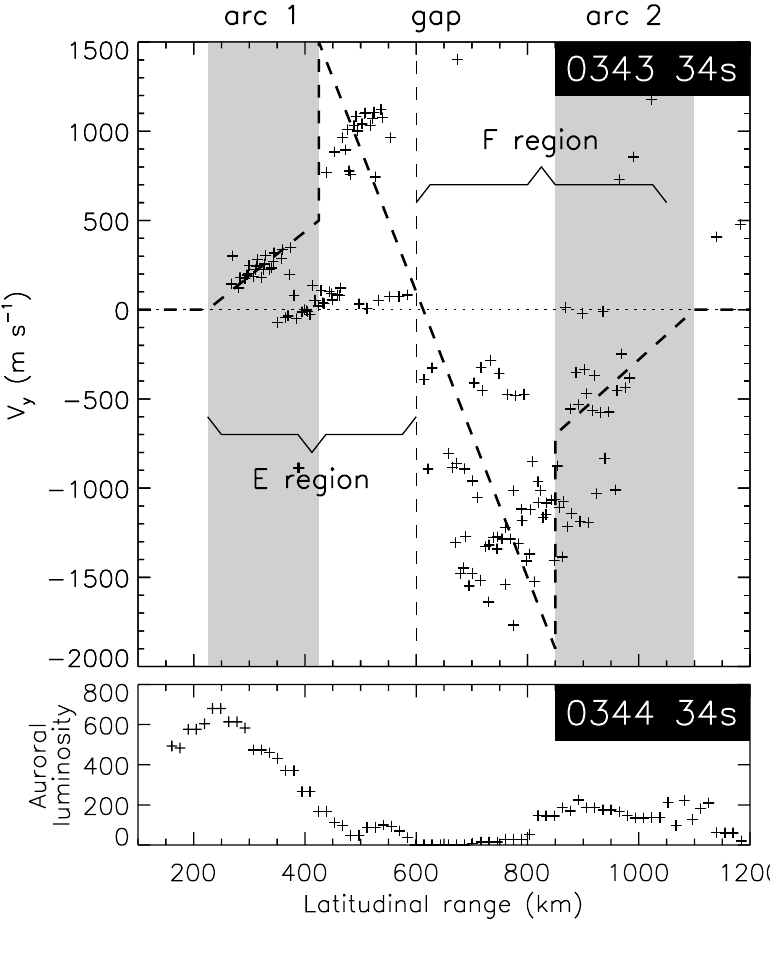
Fig. 5. (Upper panel) The plasma drift V y inferred from the Doppler shift measurements along beams 0 to 3 of the radar during the scan starting 03:43:34 UT. The dashed curve indi- cates a fit of V y from the model. Su- perimposed are grey bars indicating the location of arcs suggested by the V y fit. (Lower panel) The auroral luminosity observed by IMAGE FUV/WIC along beam 0 of the radar at 03:44:34